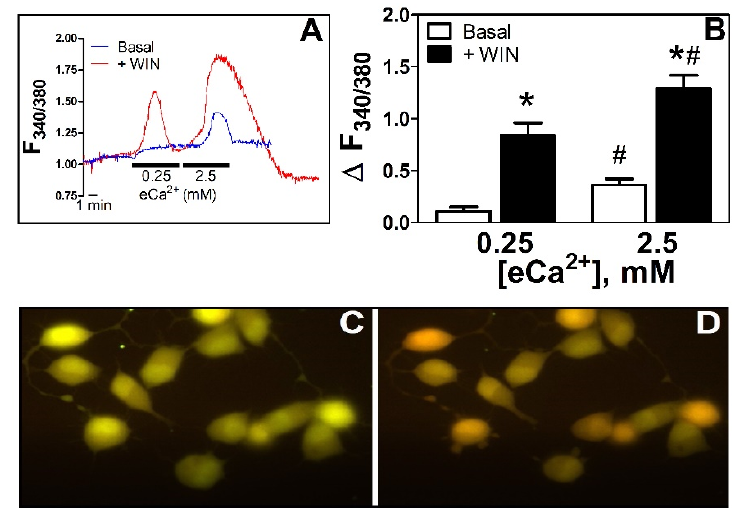
Figure 1. WIN55212-2 increases [Ca 2+ ] i : effect of eCa 2+ . ( A ). Time course of the changes in F 340/380 in N18TG2 cells incubated in 0.25 and 2.5 mM eCa 2+ in basal conditions (blue line) or the presence of WIN55212-2 5 μ M (red line). ( B ). Relative changes in [Ca 2+ ] i as Δ F 340/380 in basal conditions (Basal, □ , n = 6) or in the presence of WIN55212-2 5 μ M (+WIN, ■ , n = 7). * p < 0.05 vs. basal; # p < 0.05 vs. 0.25 mM eCa 2+ . ( C ). Fluorescence image from a representative coverslip with N18TG2 cells observed under the imaging system used (see section Imaging in Materials and Methods) in eCa 2+ 0.25 mM. 40× amplification. ( D ). Same cells as in C after 2 min treatment (approximately at peak response) with WIN55212-2 5 μ M in eCa 2+ 0.25 mM, 40x amplification. Changes in pseudo color from green to red represent the increase in emission after excitation at 340 nm and decrease in emission after excitation at 380 nm of Fura-2 upon binding to Ca 2+ , the basis of the ratiometric (F 340/380 ) system for determinations of relative changes in [Ca 2+ ] i [17].